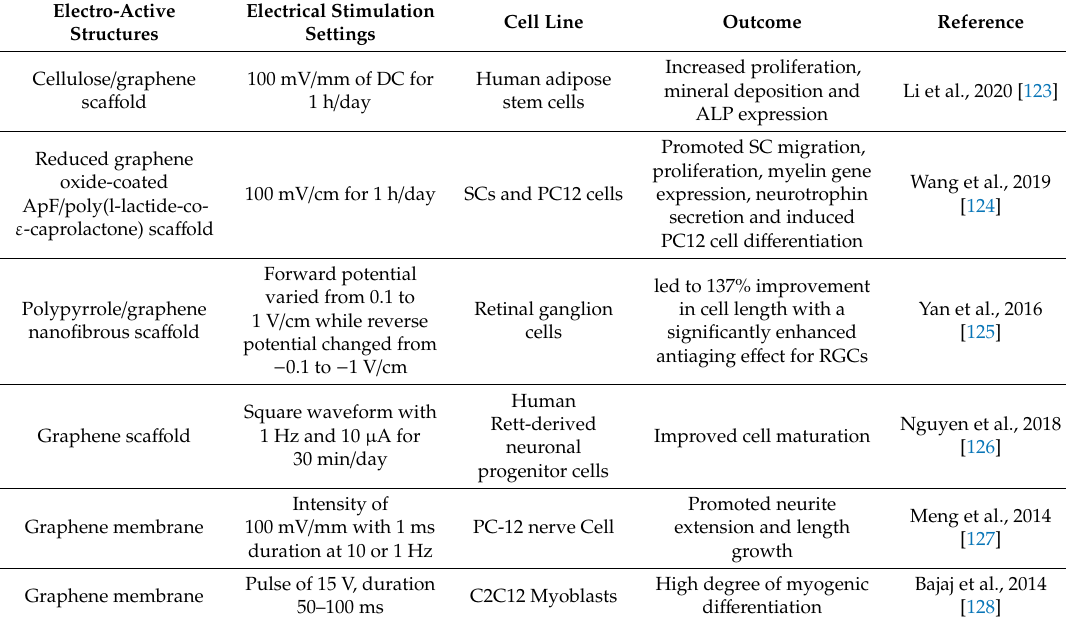
Table 2. Studies using graphene electro-active